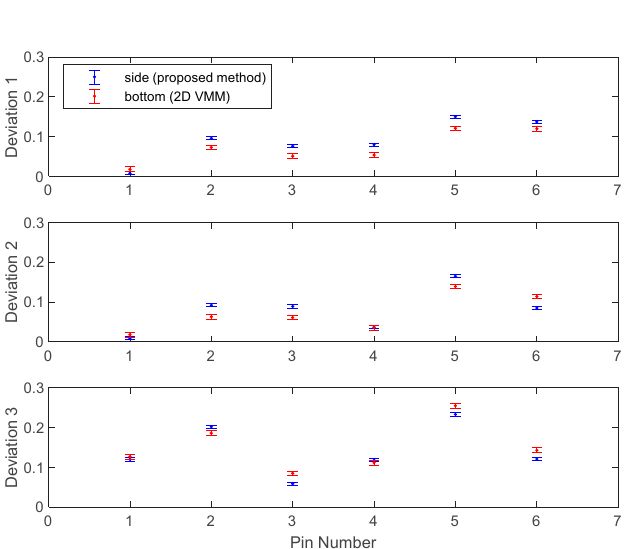
Figure 7. The deviations were obtained using the proposed method and the 2D VMM, as in Table 1. Deviations 1, 2, and 3 mean the measurement results of samples 1, 2, and 3. The uncertainty of 0.004 mm for the proposed method and that of 0.006 mm for the 2D VMM were used to generate the error bars for the corresponding data.